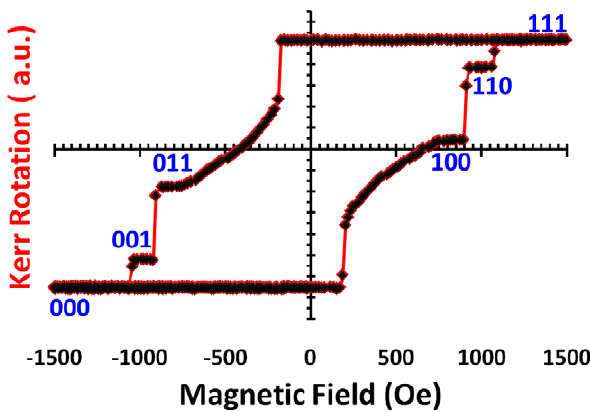
Figure 4. MOKE hysteresis loop. A graph revealing three magnetically-decoupled recording layers for the fabricated ML-3D media.